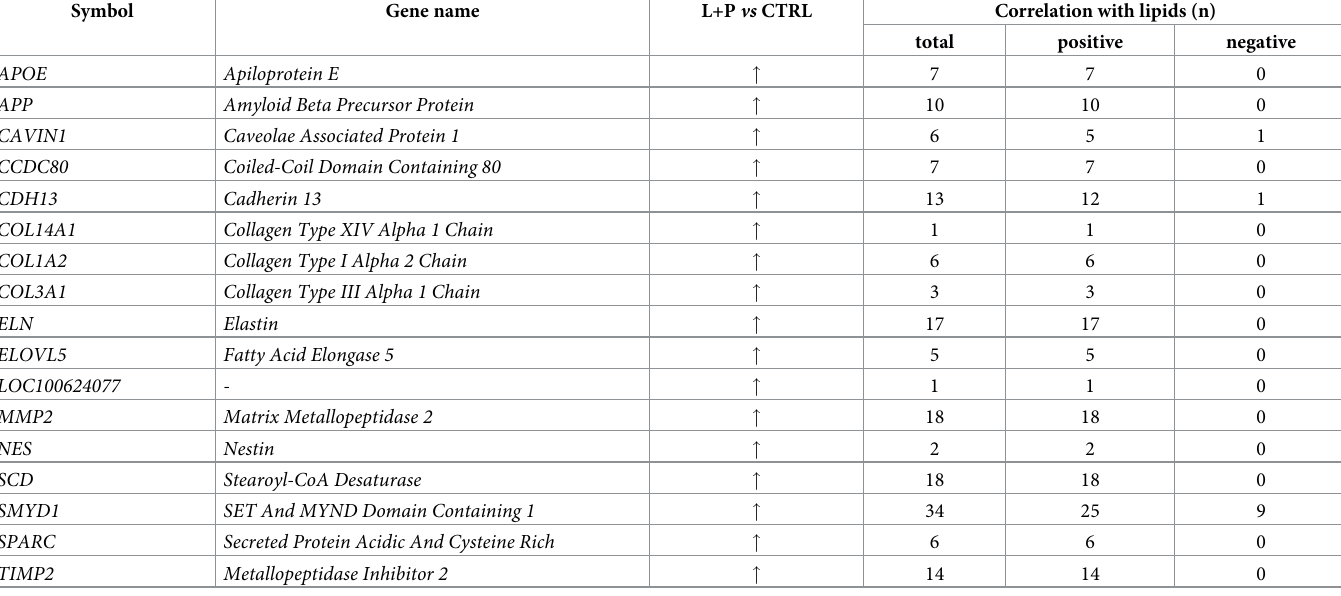
Fig 7. Cluster analysis of L+P vs CTRL comparison. Numbers represent the pig sampled and different colours indicate the clusters. Cluster 1 = CTRL; Cluster 2 = L+P. https://doi.org/10.1371/journal.pone.0264953.g007 The lipids establishing a high number of correlations were predominantly glycerolphospho- lipids (125 correlations), followed by glycerolipids (11), bile acids (11); sphingolipids (9); sulfo- nolipids (7); amino acids and derivatives (2), and sterol lipids (1). Among the genes found up- regulated in L+P, those more specifically involved in lipid metabolism and glucose homeosta- sis were Apolipoprotein E ( APOE ), Caveolae Associated Protein 1 ( CAVIN1 ), Coiled-Coil Table 4. List of genes showing significant correlation with